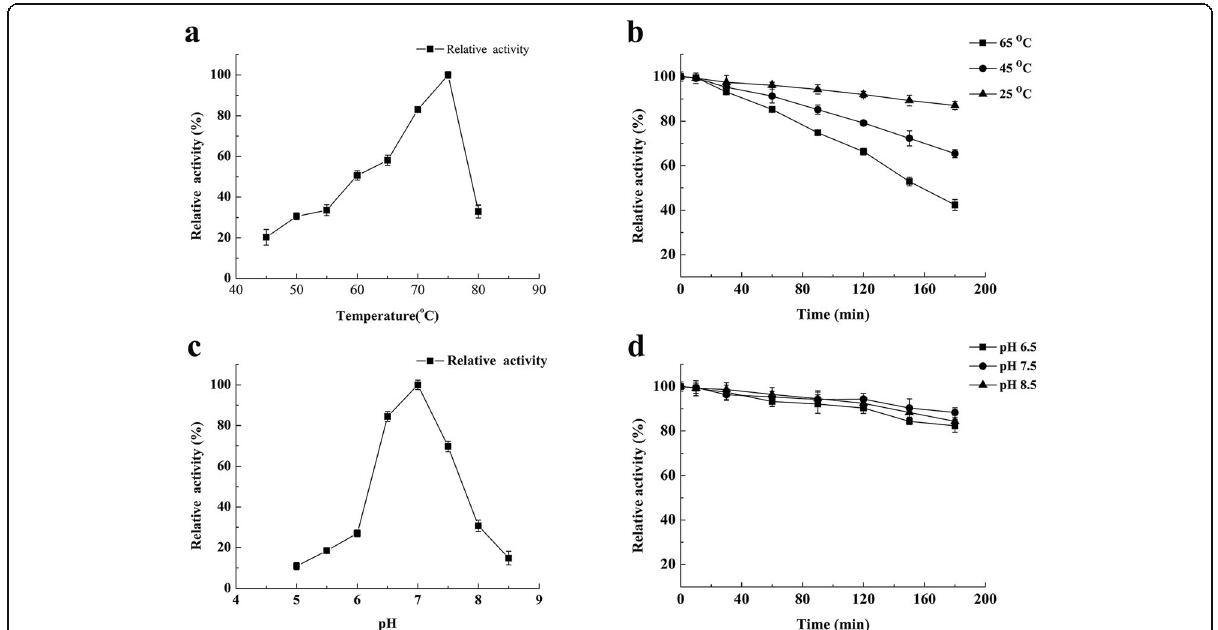
Fig. 3 Effects of pH and temperature on the activity and stability of LacAn. a Optimum temperature of LacAn for enzyme activity was measured in 50 mM Na 2 HPO 4 -KH 2 PO 4 at pH 7.0 with syringaldazine as a substrate. b Thermostability was investigated at 25 °C (triangle), 45 °C (circle), and 65 °C (square) by determining the enzyme activity under the same conditions as above. c Optimum pH of LacAn for enzyme activity was